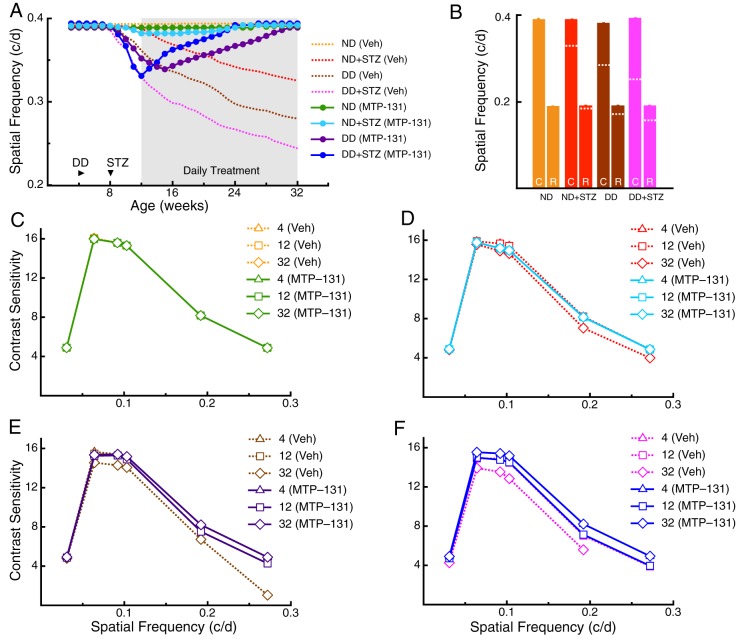
Reversal of visual dysfunction following daily systemic treatment with MTP-131. Daily MTP-131 treatment is indicated by shading. Dotted lines are traces from Fig. 1, depicting the effects of Veh treatment. (A) Improvement of SF function was present within 2 weeks of treatment in ND+STZ mice [MTP-131 versus Veh; 0.382±0.001 c/d (n=7) versus 0.377 c/d±0.006 (n=12)], within 3 weeks in DD mice [MTP-131 versus Veh: 0.342 c/d±0.001 (n=8) versus 0.347 c/d±0.003 (n=7)] and within 1 week in DD+STZ mice [MTP-131 versus Veh: 0.340±0.001 c/d (n=11) versus 0.313±0.002 c/d (n=6)]. Full restoration of function was achieved by 24 weeks in ND+STZ (n=4) and DD+STZ (n=8) mice, and by 31 weeks in DD mice (n=5). ND (MTP-131) did not differ statistically from ND (Veh) at any age (n=6, P>0.05). (B) Cone- and rod-mediated function was restored by MTP-131 treatment, as measured at 28 weeks of age (P>0.05); dotted lines depict the results of Veh treatment abstracted from Fig. 1. (C-F) MTP-131 restored normal CS in each experimental group by 32 weeks.